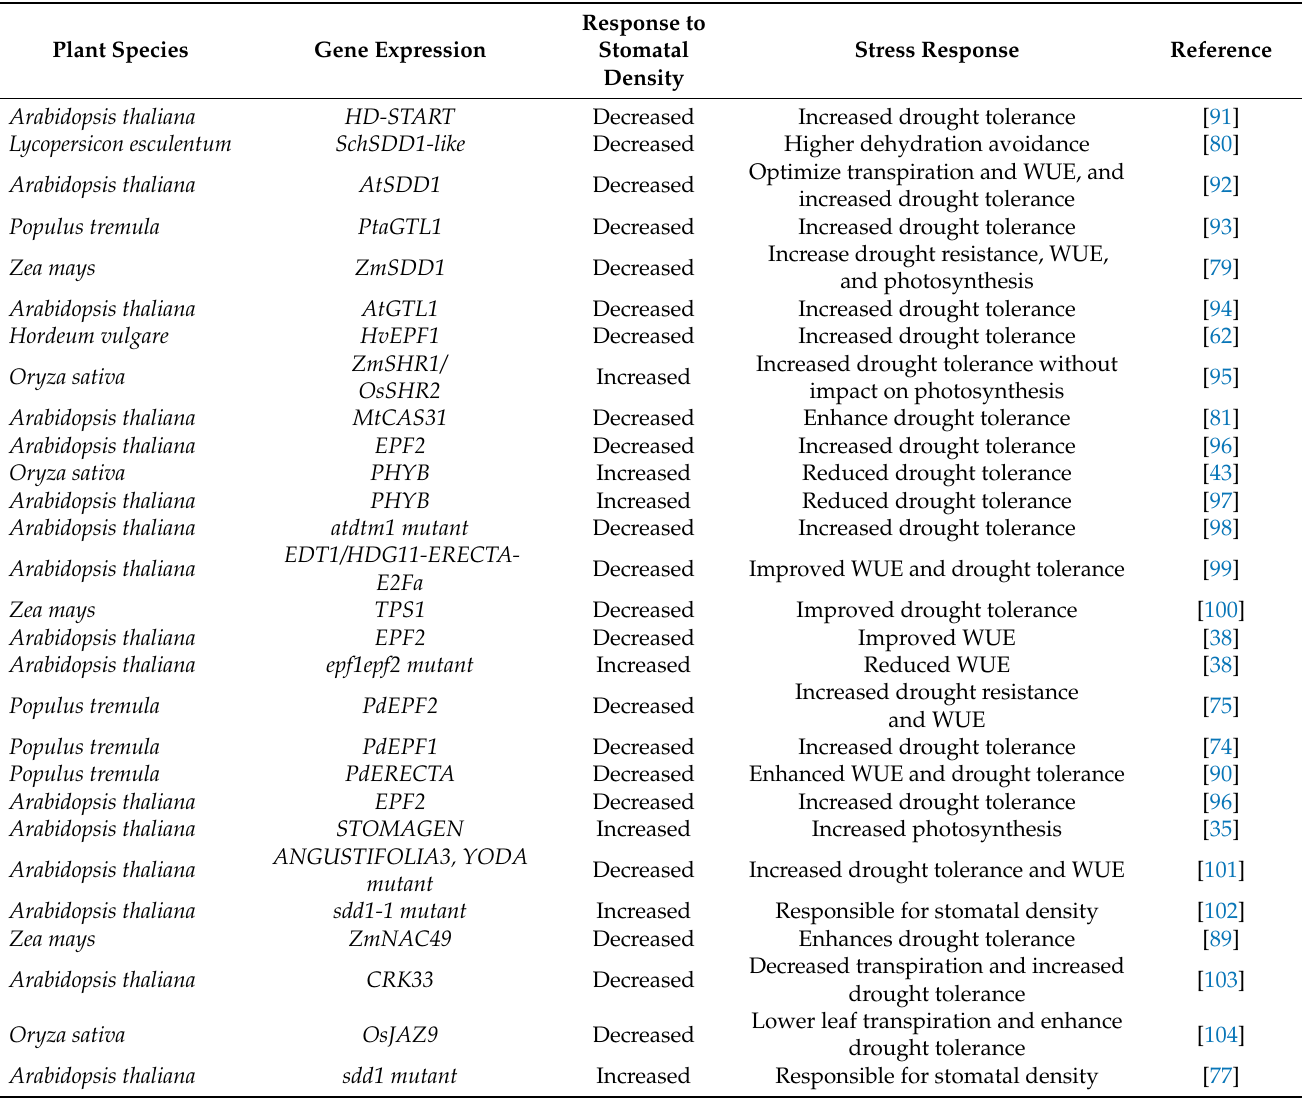
Table 2. Genes involved in the regulation of stomatal density in plants under osmotic